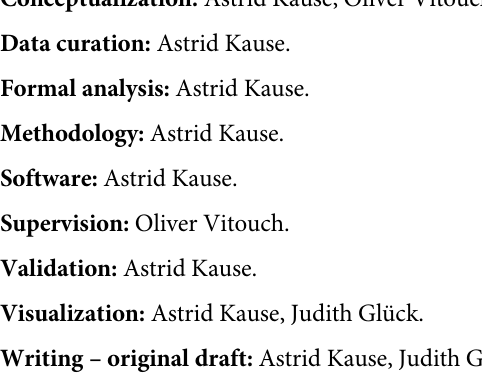
S3 Table. Table A. Bayesian correlation between thirst and water offered; proposers, respond- ers. All Bayesian Analyses were conducted using JASP [40]. Table B. Bayesian one-way ANOVA for amount shared (100, 150, 200 ml; 5, 7.5, 10 € ), by amount to be shared; proposers. Table C. Correlation of water offers with monetary offers, proposers, and expectations of responders. Table D. Bayesian paired samples T-Test; water offers with monetary offers; pro- posers; and expectations by